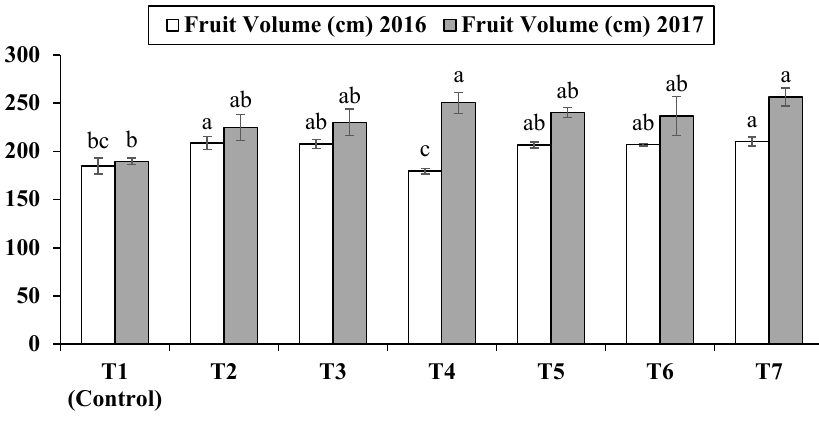
Figure 3. Effects of foliar application of variable sources of Ca and K with B on SB Chaunsa fruit volume